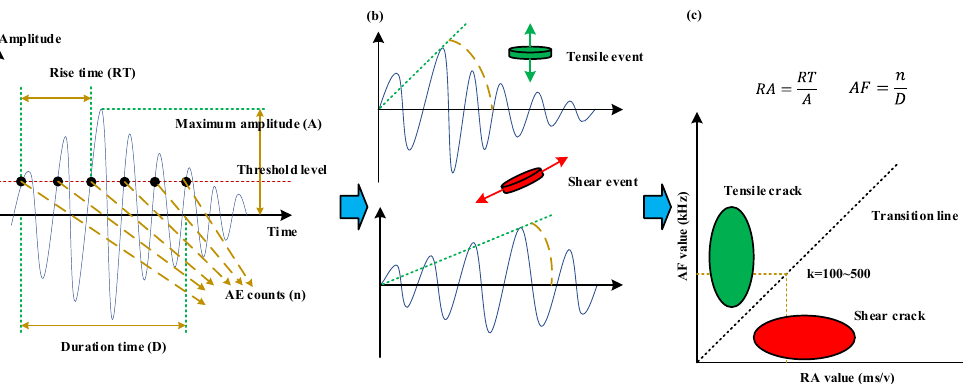
Figure 10. Classification of tensile and shear cracks based on AE parameter analysis: ( a ) Graphical representations of AE characteristic parameters; ( b ) Comparison between typical waveform of tensile event and shear event; ( c ) Crack classification methods in AE parameter analysis.